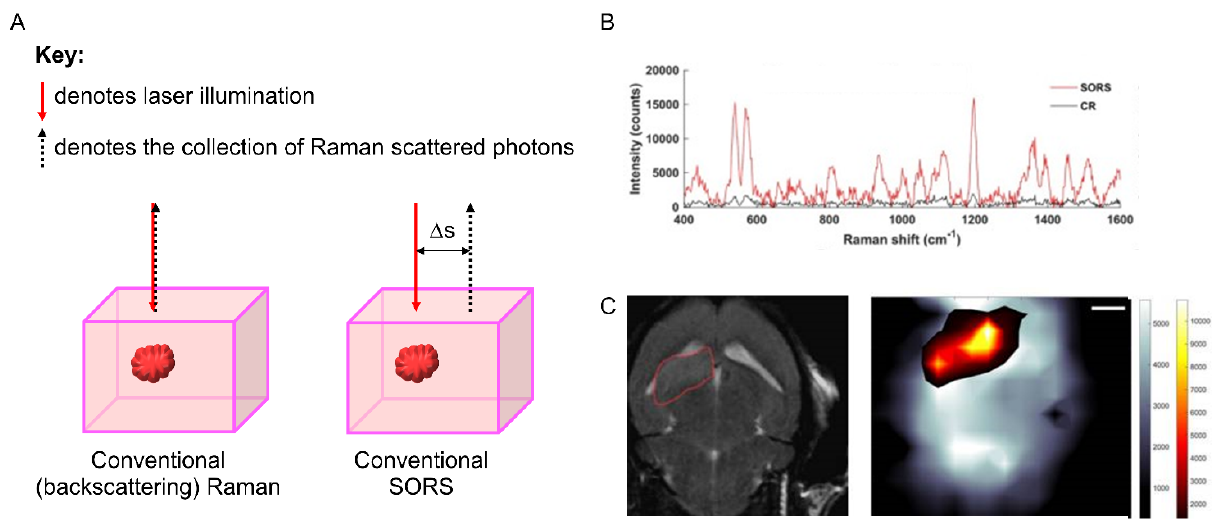
Figure 4. ( A ) Schematic diagram detailing the excitation and collection configuration for conventional (backscattered) Raman, where the laser excitation and Raman scattered photon collection are at the same point. In a conventional SORS experiment, the point of collection is offset from the excitation by a spatial offset ( ∆ s). Adapted from [15] with permission from the Royal Society of Chemistry (copyright 2021). ( B ) Non-invasive in vivo imaging of integrin-targeting SERRS nanoparticles through the skull in GBM-bearing mice by means of conventional Raman (CR) and SORS. Representative CR and SORS spectra from a point of maximum intensity of the SERRS NPs are provided in ( B ). ( C ) 2D axial T2 ‐ weighted MRI scan confirming the presence of a left frontal tumour (outlined in red). SORS heatmap of the bone (greyscale) and SORS heatmap of the SERRS NPs (red hot) are overlaid and correlate with the tumour region highlighted in the MRI scan. Images reproduced from [17] with permission from Ivyspring International Publisher (copyright 2019).